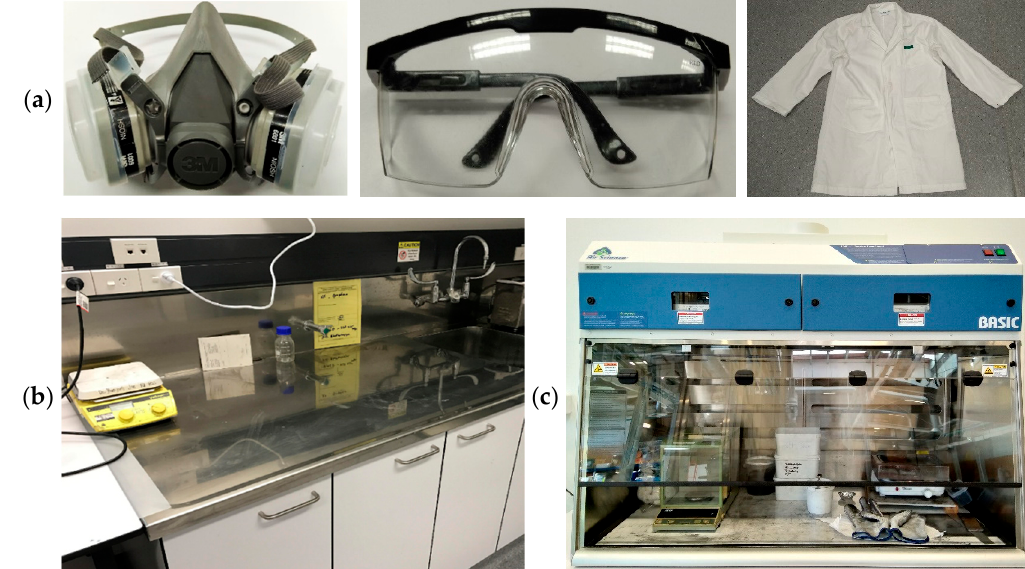
Figure 4. ( a ) Illustration of basic personal protective wear while handling with nanomaterials under nano-enclosure (HEPA filtered mask, fully covered eye glasses and lab coat), ( b ) image of after cleaning of working areas, and ( c ) a typical nano-enclosure equipped with HEPA filter where graphene or similar nanomaterials should be handled under.